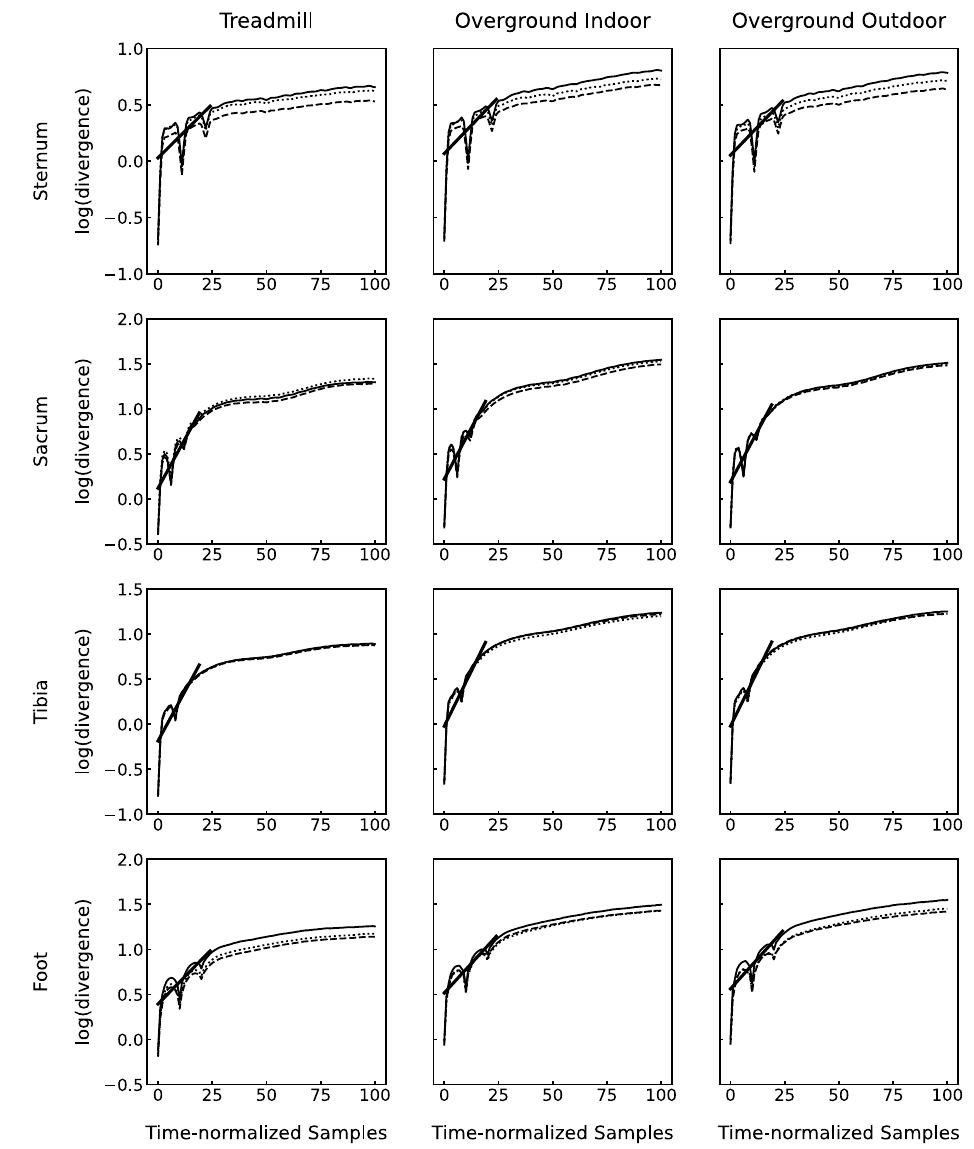
Figure 1. Average logarithmic divergence plots over all 25 participants for all conditions and sensor locations. Solid, dashed, and dotted lines represent data from the first, second, and third visits, re- spectively. Thick solid lines are the linear fit through the region of initial rapid divergence (exemplary for visit 1 only), representing running stability.